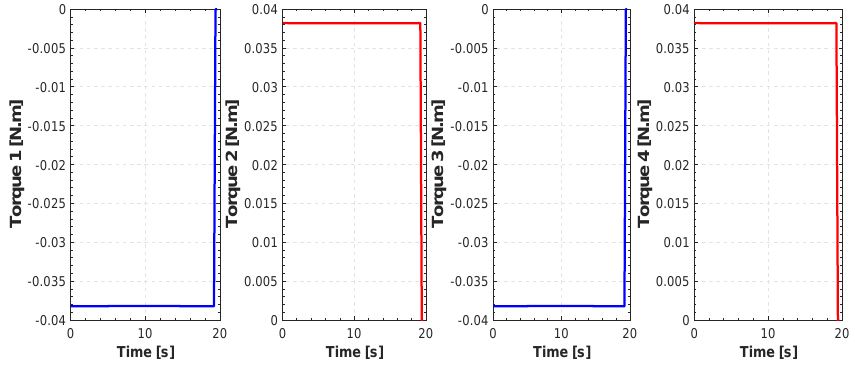
Figure 8. Evolution of actuators torques for FL.